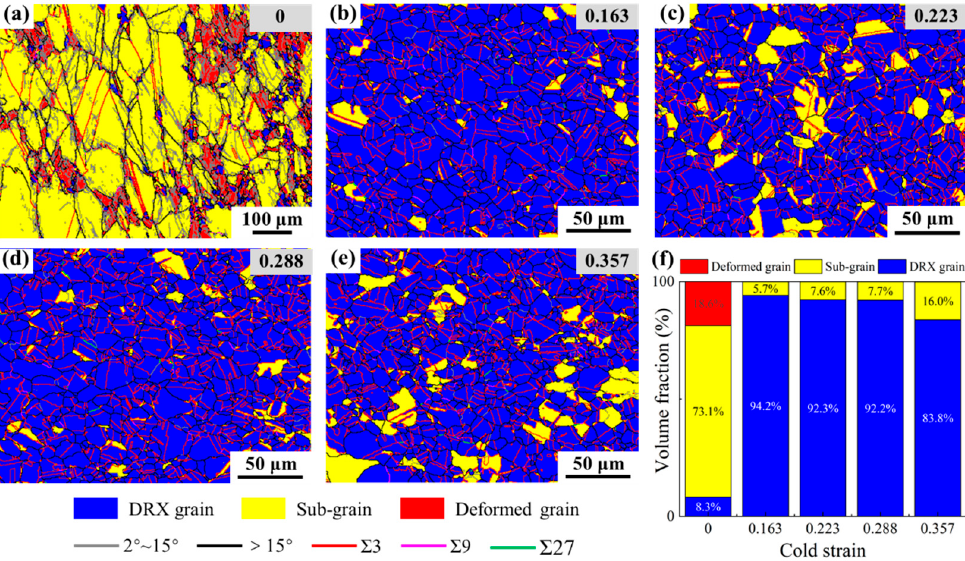
Figure 8. EBSD maps, highlighting the DRX volume fraction and grain boundary network ( a – e ) and the variations of the volume fractions of the DRX grain, sub-grain, and deformed grain, ( f ) after two- stage deformation with different prior cold strains and the same thermal deformation condition.